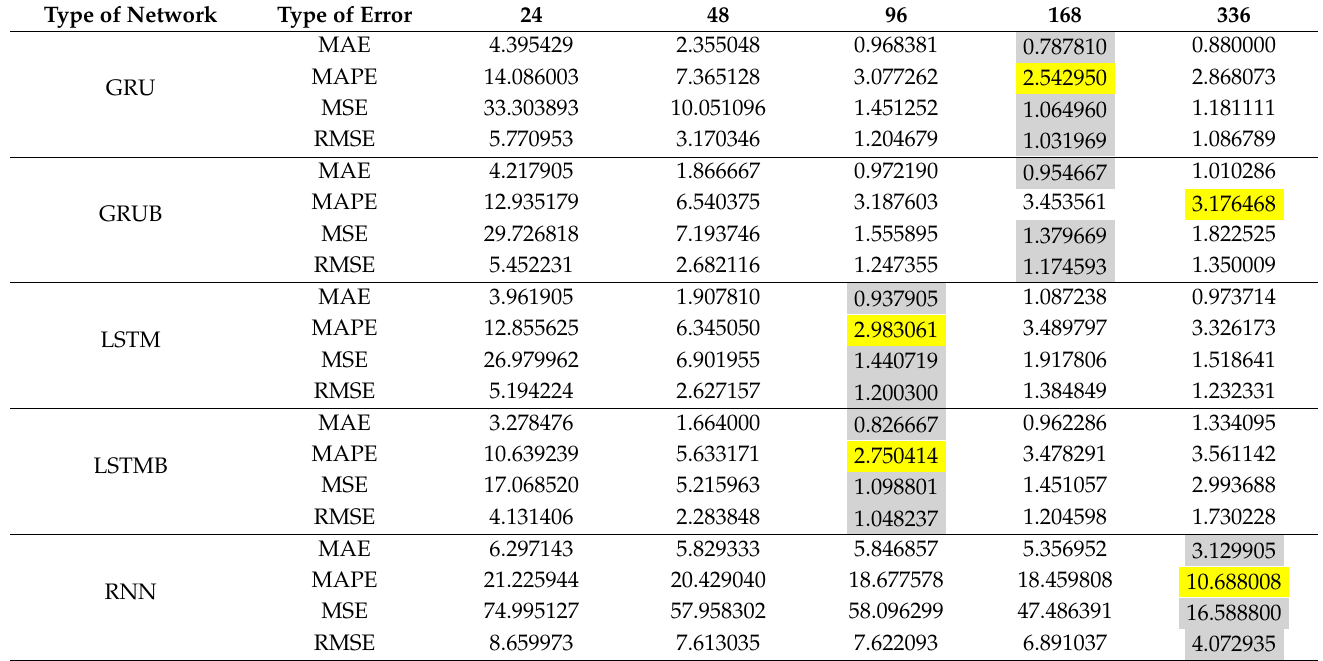
Table 4. Errors for different network structures and different horizons (spring